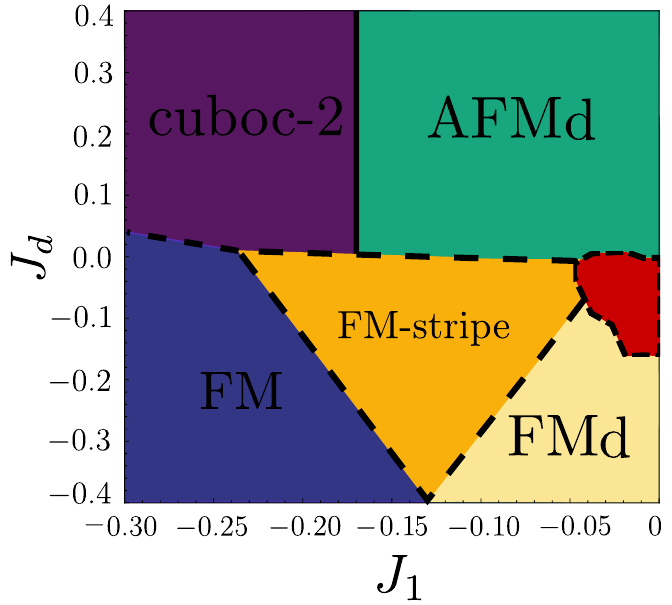
Figure 2: Classical phase diagram for the model in Eq. (1) on the kagome lattice with J χ = 1 setting the energy scale. We have five semiclassical ordered states: cuboc-2, AFMd, FM (ferromagnetic), FM-stripe, and FMd. Black dashed lines indicate first- order phase transitions. The solid line between the cuboc-2 and the AFMd phases indicates a continuous transition. A classically disordered region, in red, is present = J = around the point J d 1